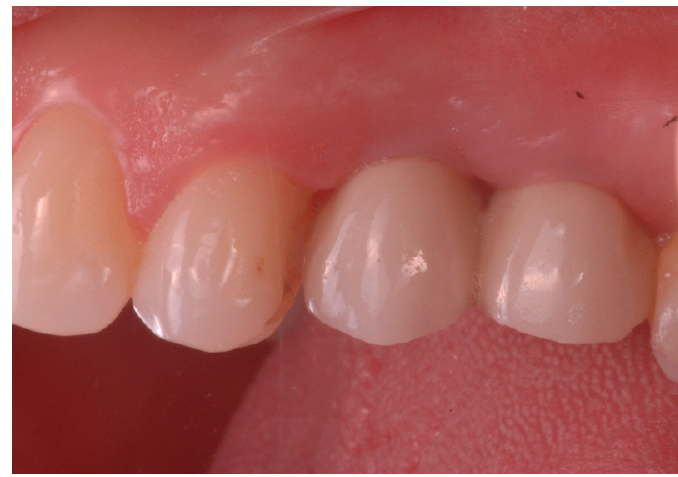
Figure 5. Clinical appearance of vestibular and inter-proximal soft tissues around adjacent implants loaded with tapered abutment.